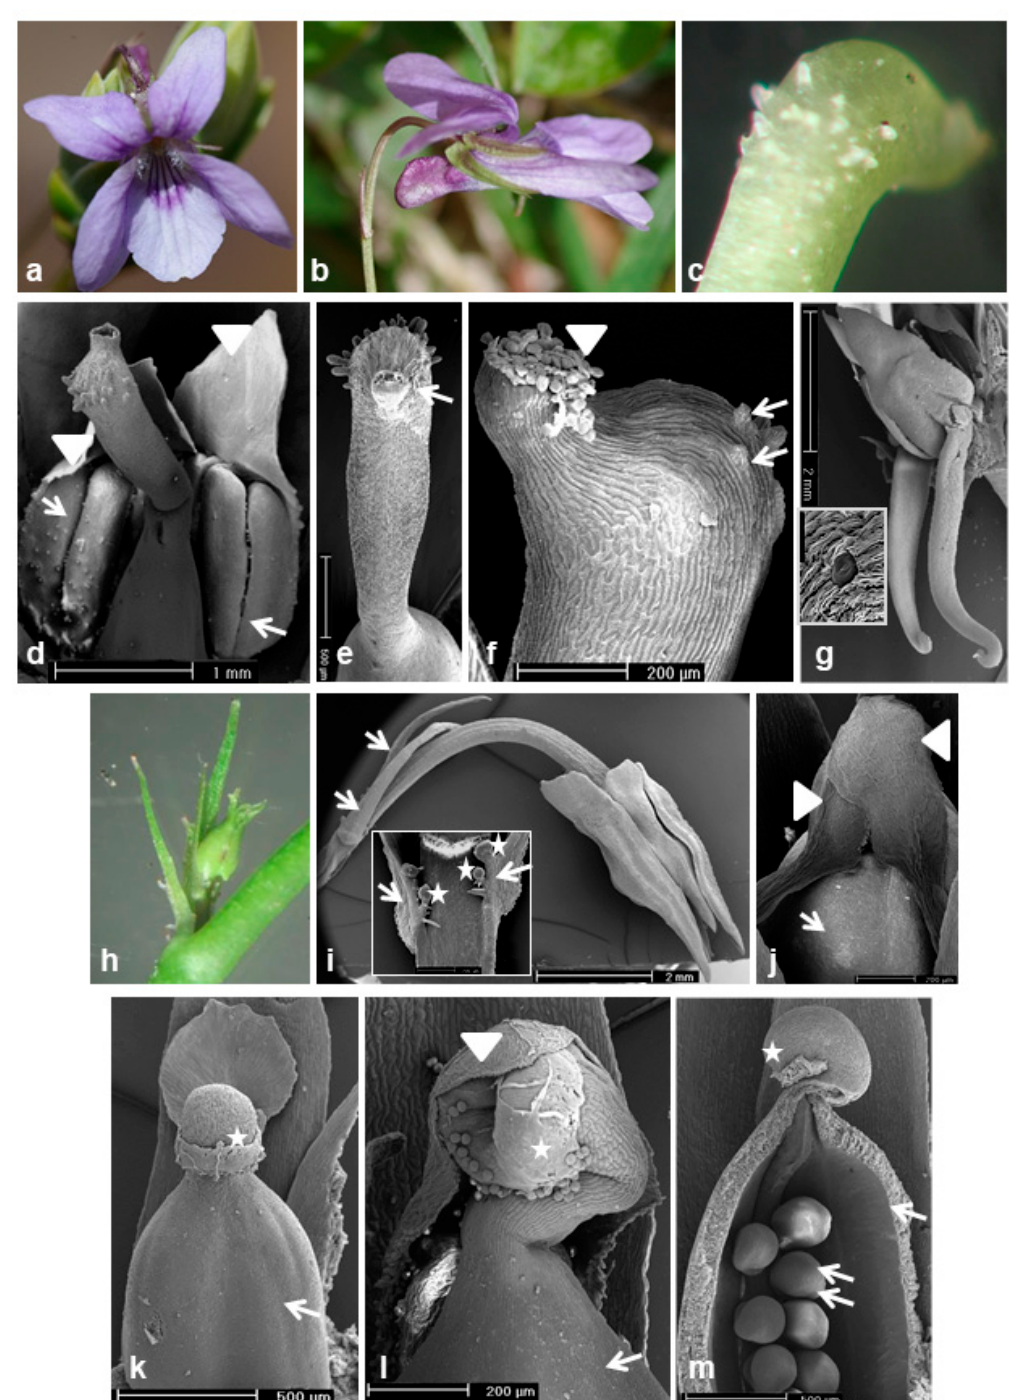
Figure 2. Viola reichenbachiana : ( a – g ) floral structure of CH and ( h-m ) CL flowers. ( a ) Face view of flower. ( b ) Lateral view of flower, spur of flower visible. ( c ) Style with head-like hairy/papillous stigma of pistil. ( d ) Pistil and anthers (arrows) with appendages (arrowheads). ( e , f ) Style with hairy/papillous stigma ( e , arrow), stigma hole filled with pollen grains ( f , arrowhead), hairs/papillae on head-like stigma ( f , arrows). ( g ) Long anther appendages (nectaries) inserted into the spur in CH flower, stomata of nectaries (inserted). ( h , i ) CL flower, glands (asterisk) located close to bracts (arrows) inserted in ( i ). ( j ) Appendages of two reduced anthers (arrowheads) covering stigma, enlarged ovary (arrow). ( k – m ) Pistil with enlarged ovary (arrows) and curved style with stigma (asterisks), visible anther appendage (arrowhead) and germinated pollen grains on stigma ( l ), ovules in open ovary ( m , doubled arrows). ( d – g , i – m ) SEM micrographs.